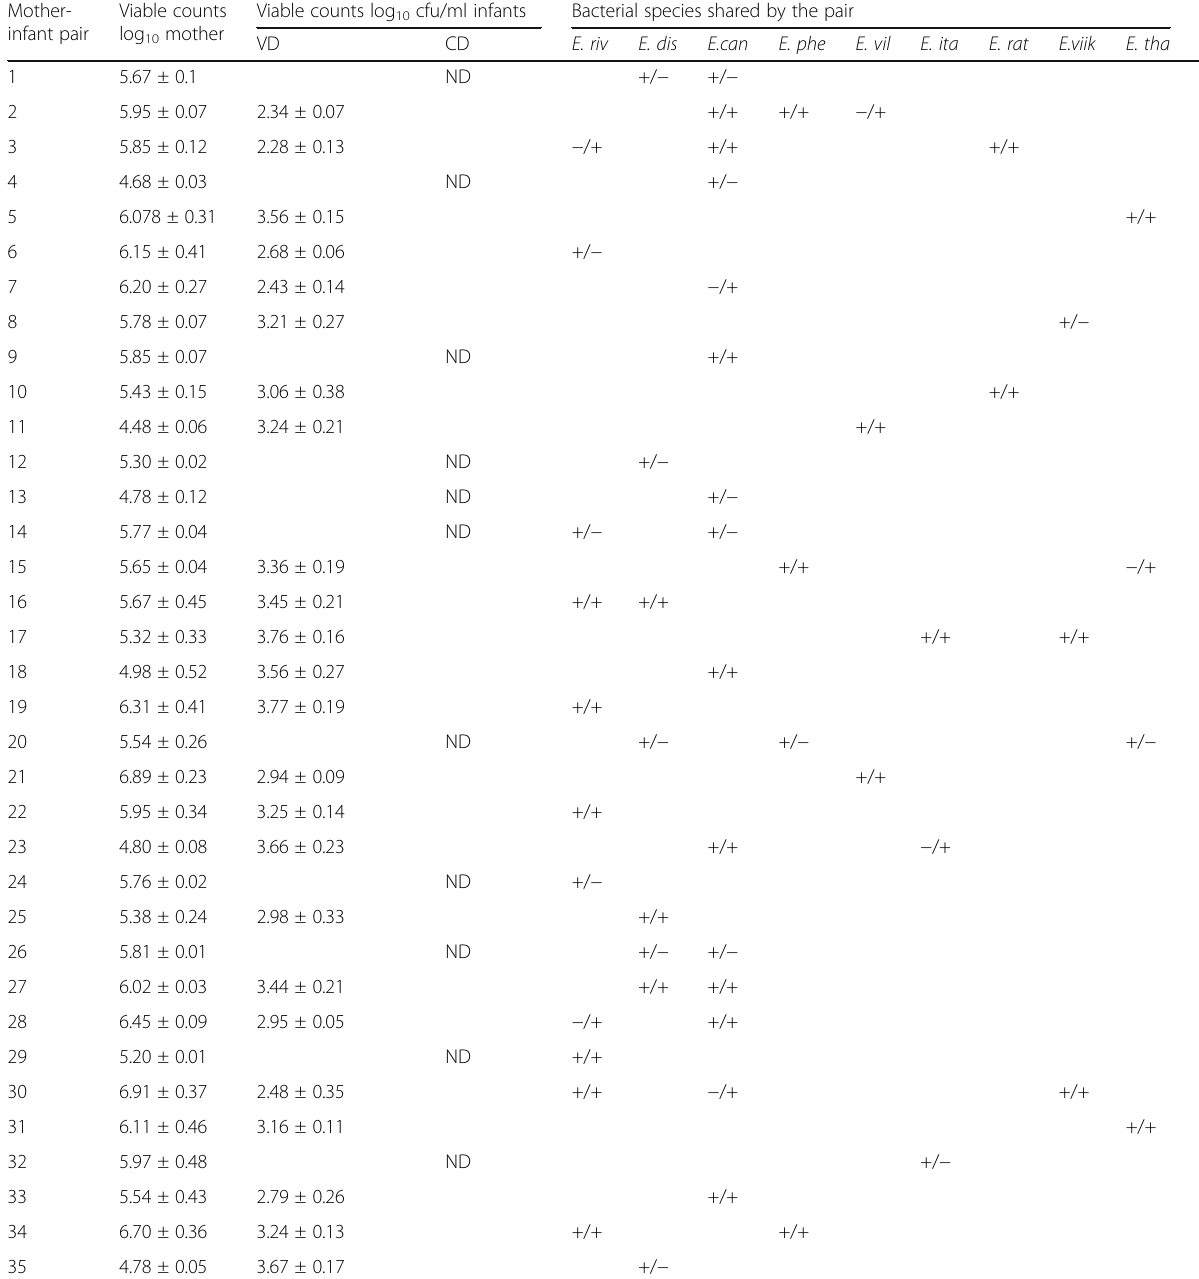
Legend: Values are mean log 10 cfu/mL (vaginal fluid) or log 10 cfu/g (feces) ± standard deviation E. riv , Entercoccus rivorum ; E. dis , Enterococcus dispar ; E. can , Enterococcus canintestinii ; E. phe , Enterococcus pheoniculicola ; E. vil , E villorum ; E. ita , Enterococcus italicus ; E. rat , Enterococcus ratti ; E. viik , Enterococcus viikiensis ; E. thai , Enterococcus thailandicus ; VD , vaginal delivery; CD , cesarean delivery; N , number of bacterial species shared by the pair; +/+, bacterial species was present in both the both mother and infant sample; +/ − , bacterial species was present in the mother but absent in the infant; − /+, bacterial species absent in mother but present in infant; ND , not